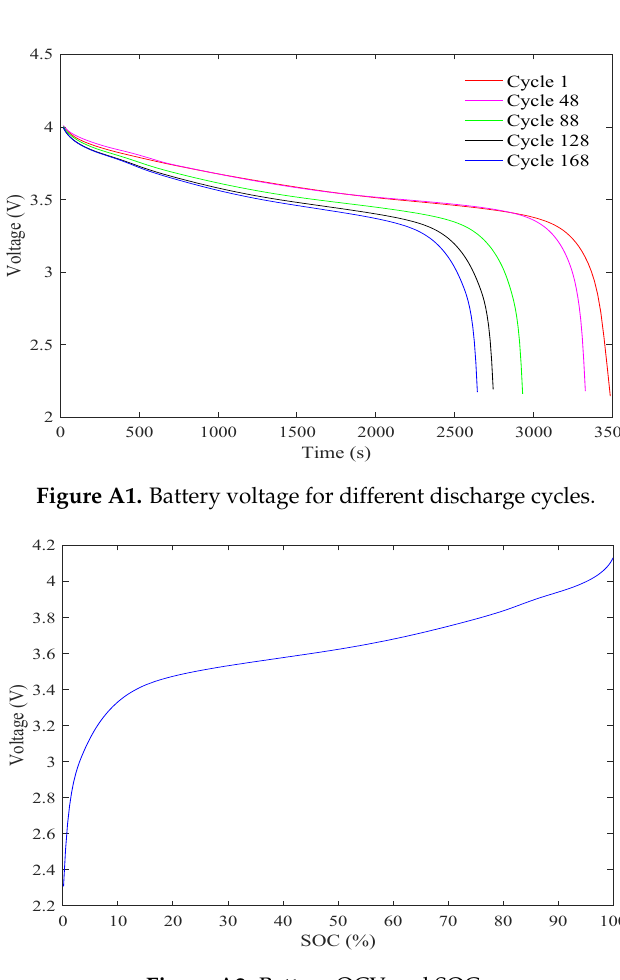
Figure A2. Battery OCV and